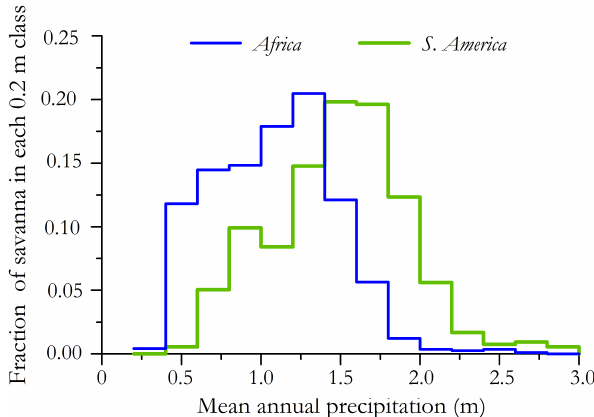
Figure 12. Distribution of savanna vegetation formation types (in- cluding grasslands) in Africa and South America in relation to mean annual precipitation. Original data from Lloyd et al.